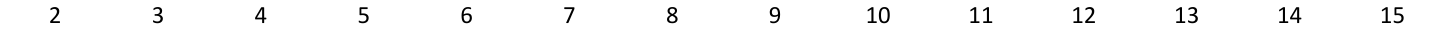
Table 2. Correlation